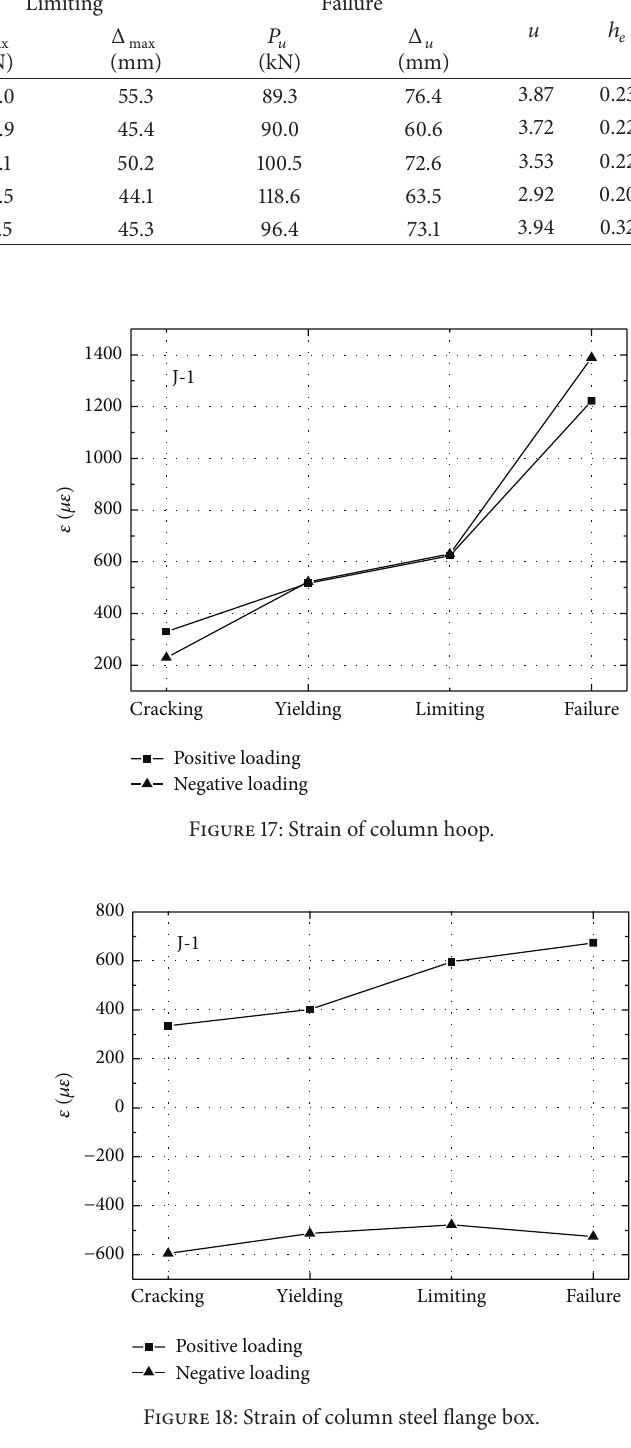
Figure 18: Strain of column steel flange